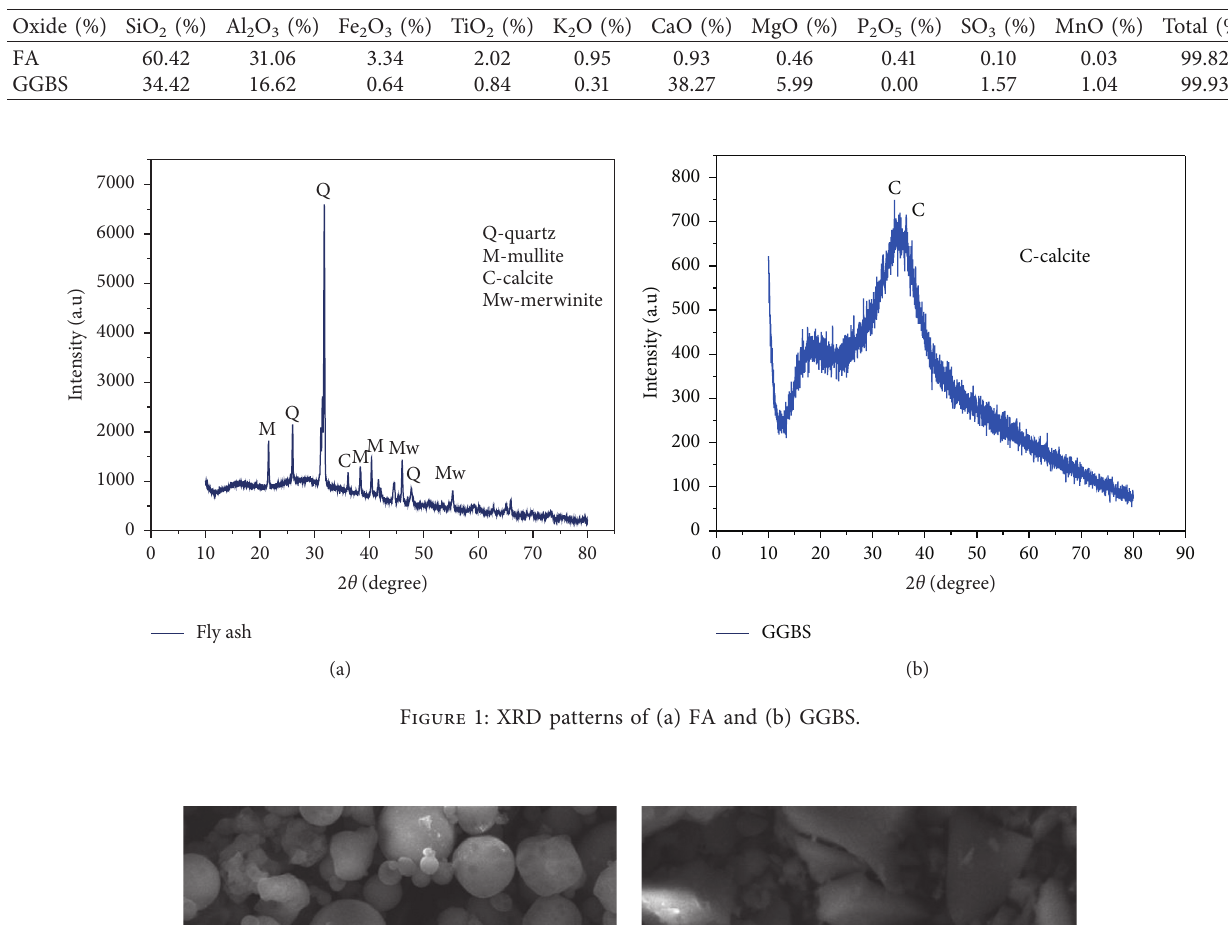
Table 1: Chemical composition of FA and GGBS from XRF analysis.